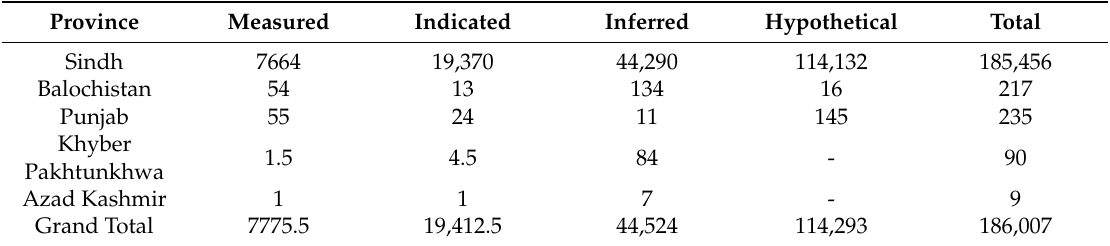
Table 1. Pakistan coal reserves as on 30 June 2014 (million